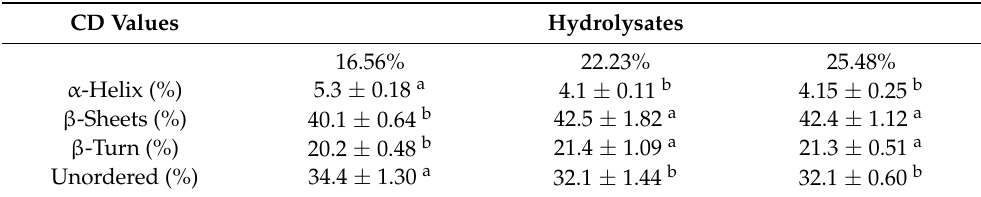
Table 2. Secondary structure composition of bighead carp protein hydrolysates obtained using the flavourzyme enzyme at different degrees of